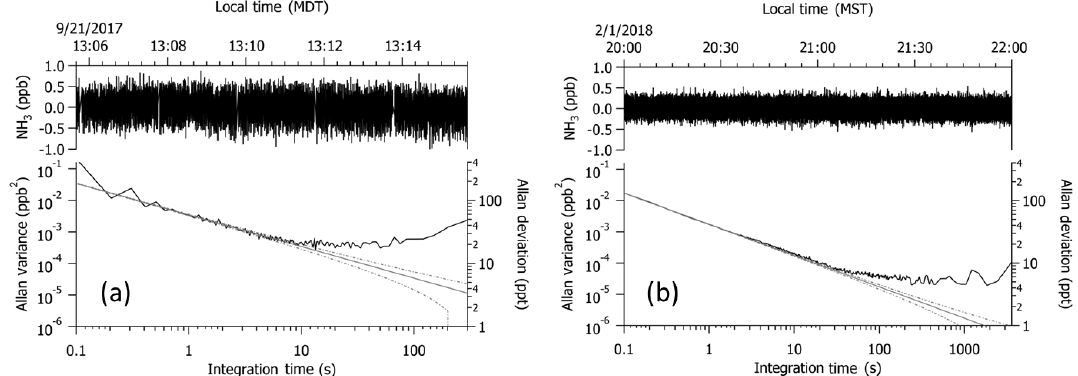
Figure 2. 10Hz measurements collected while overblowing NH 3 -free air at the inlet tip (a) in flight in the boundary layer near 1.4kma.g.l. and (b) on the ground in the laboratory. Upper traces represent the raw 10Hz data collected; lower traces depict the Allan variance of the corresponding data set. An offset of − 150pptv was applied to the noise guidelines (gray and dashed lines) in panel (a) to account for differences induced by the vibration applied to the laser objective to reduce motion sensitivity in flight; the vibration was not applied during laboratory tests depicted in panel (b)